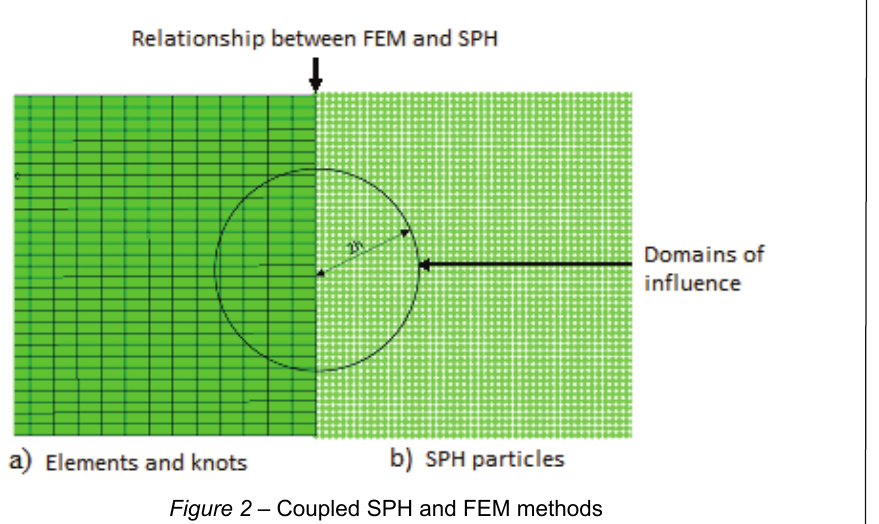
Figure 2 – Coupled SPH and FEM methods Рис . 2 – Сопряженный SPH и FEM